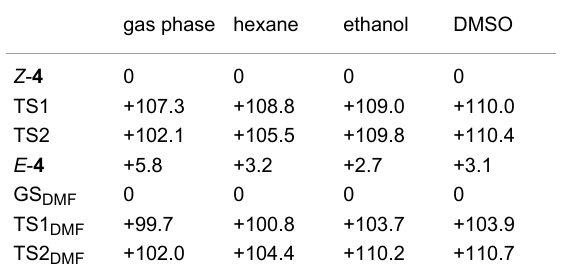
Table 1: Relative Gibbs free energy (kJ/mol) for E - 4 , Z - 4 , TS1, TS2,